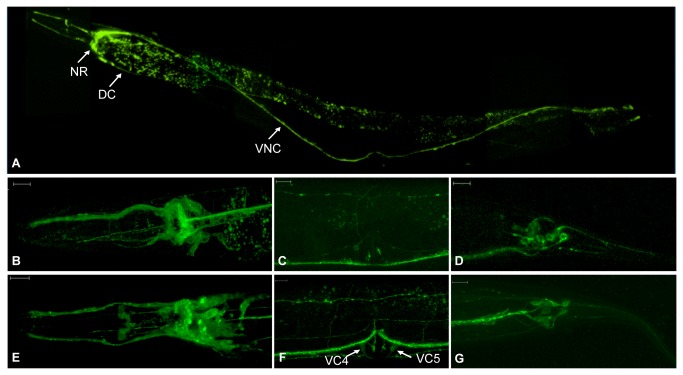
Expression pattern of KCNL-2.A. The kcnl-2 gene was amplified from the WRM063DE08 fosmid and GFP was fused to the latter stop codon to produce a translational gene fusion that tagged the channel at the carboxy terminus. p
kcnl-2
kcnl-2(taa2)::gfp localized to the neurons of the head, the NR, motor neurons of the VNC, the DC, the pharyngeal nervous system, and to tail ganglia (widefield fluorescent image of strain VK1567). B–G. Magnified confocal images of p
kcnl-2
kcnl-2(taa2)::gfp (B–D) and p
kcnl-2
gfp ::(atg2) kcnl-2 (E-G; strain VK1401) when expressed in the N2 background (Scale bar=10 µm). B,E. Neurons of the head, the pharyngeal nervous system, and cell bodies of the nerve ring. C. Neuronal processes innervating the vulva. F. Neuronal processes at the vulva, including the VC4 & VC5 cell bodies (arrows). D,G. Tail ganglia.